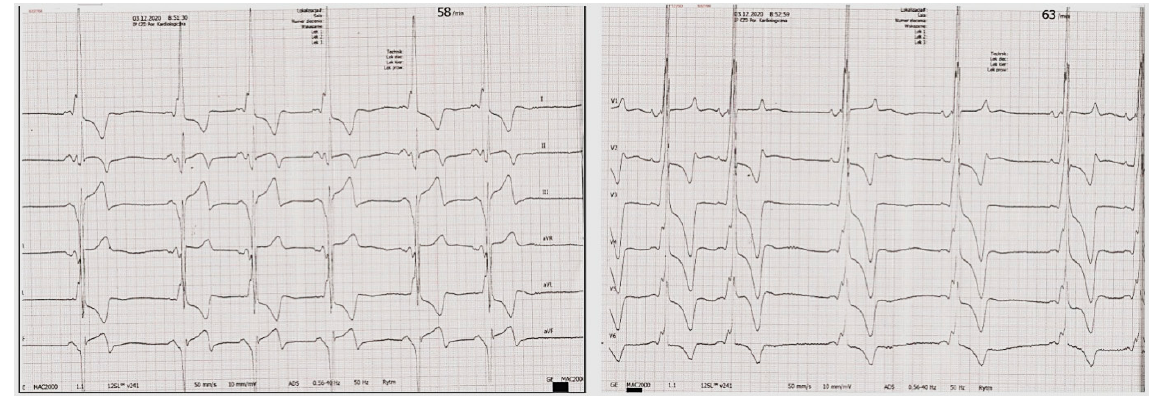
Figure 1. Twelve-lead ECG recording showing the features of the Wolff–Parkinson–White syndrome in a patient with LVNC.